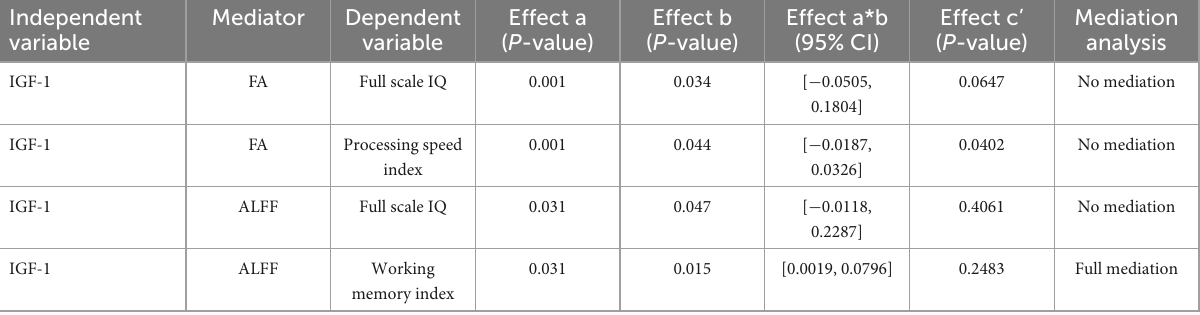
TABLE 3 Mediation effects between serum IGF-1 levels and neuropsychological assessment scores. Independent variable